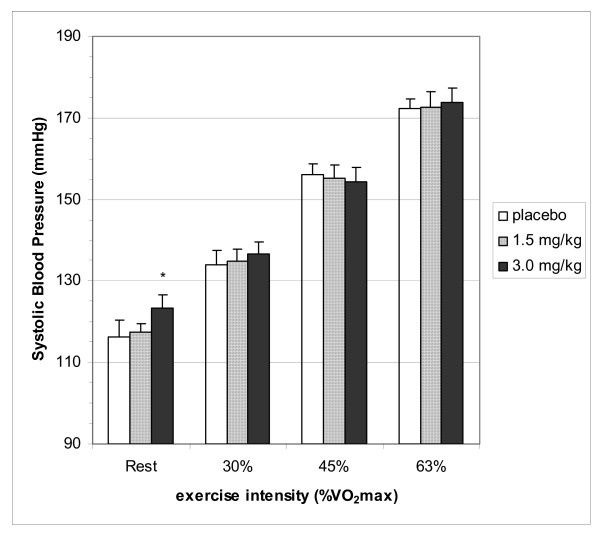
Systolic blood pressure at rest and during exercise. Differences in Systolic blood pressure between placebo and caffeine trials. Placebo, 1.5 and 3.0 represent dose of caffeine in mg·kg body weight-1. Values are listed as mean ± SE. * = the mean difference compared to placebo is significant (p < 0.05)